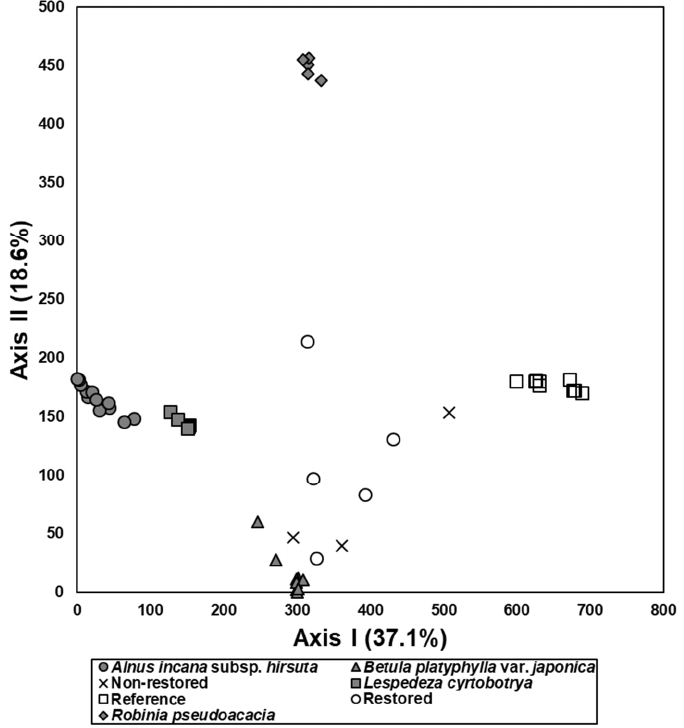
Figure 7. DCA ordination of vegetation including sites restored ecologically (restoration), rehabili- tated applying silvicultural method ( Alnus incana subsp. hirsuta , Betula platyphylla var. japonica , Lespedeza cyrtobotrya , and Robinia pseudoacacia ), and reference stands dominated by Quercus mongol- ica .